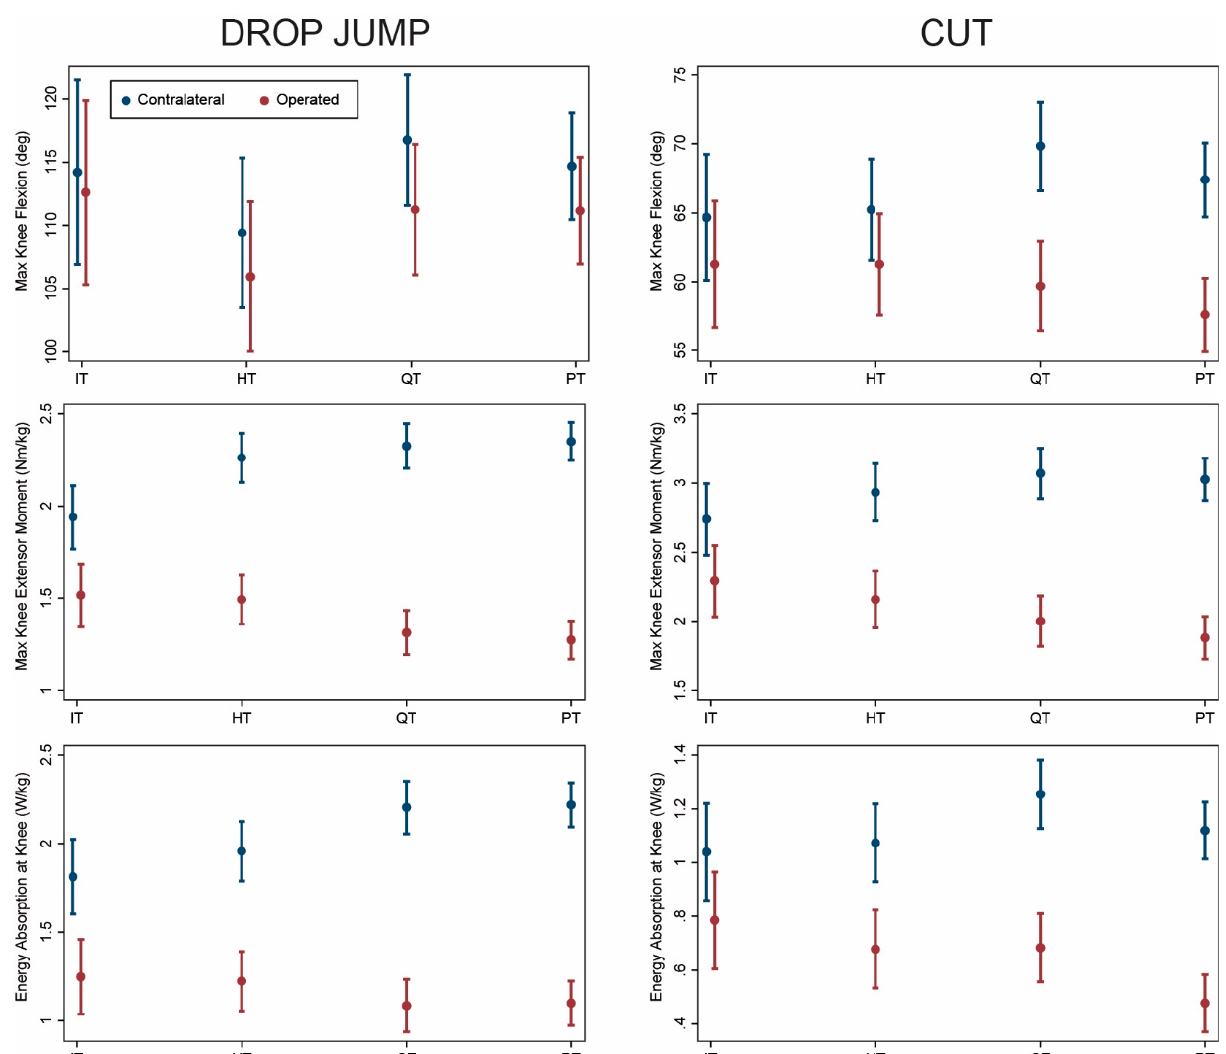
Figure 1. Comparison of operated (red) and contralateral (blue) limbs by graft type (model predicted mean and 95% confidence interval) for complete sample. IT: iliotibial band; HT: hamstring tendon; QT: quadriceps tendon; PT: patellar tendon.